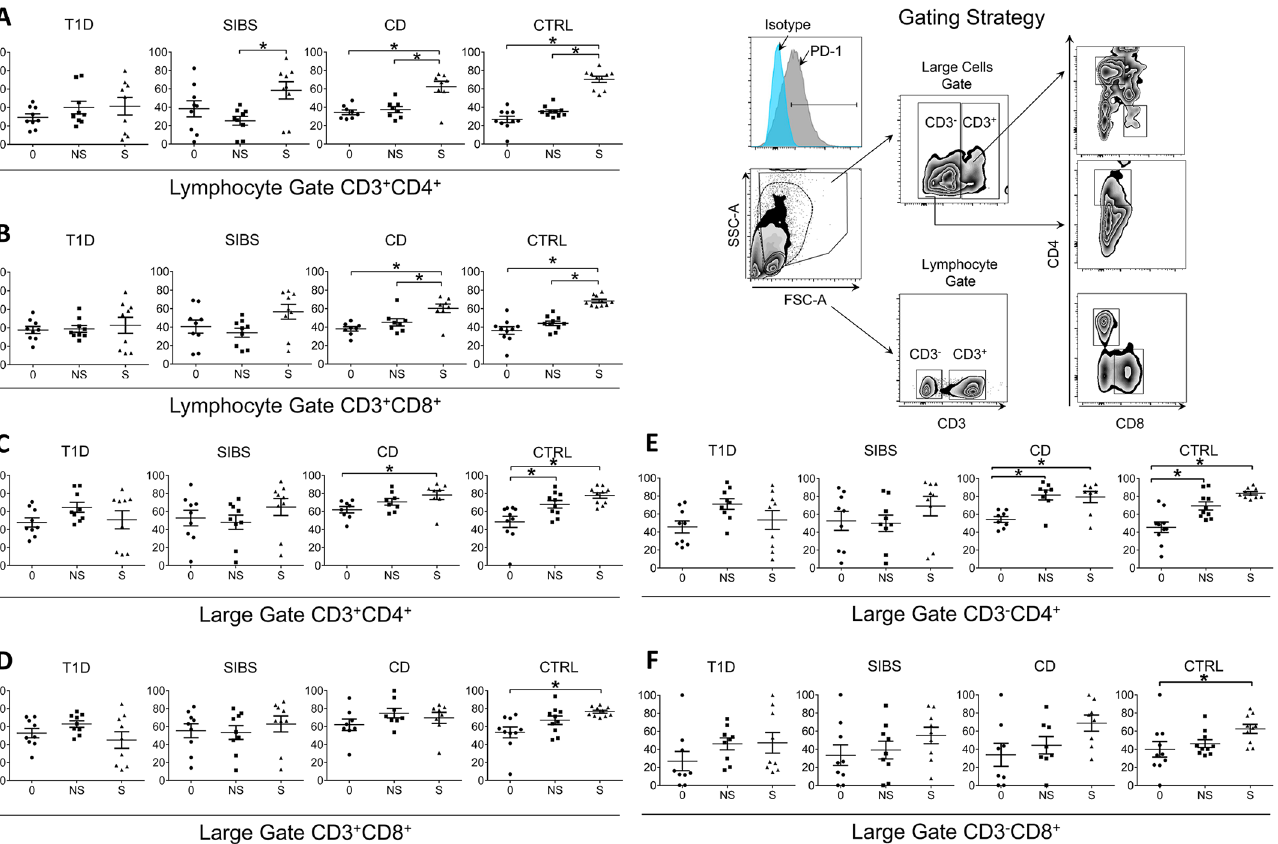
Fig 1. T Cells from T1D fail to upregulate PD-1 upon stimulation. Freshly isolatedPBMCs were stained with antibodiesagainstCD3, CD4, CD8, and PD-1 and analyzedby flow cytometry. Lymphocytes were identifiedby forward and side scatter and interrogatedfor CD4 and CD8 expression (bottom of right panel,lymphocyte gate). Another gate with higherside scatter identifiedlarger cells that includemonocytes and activated T cells (top of right panel, large gate). Mean percentage expressionof PD-1 was compared by one-wayANOVA on each of the PBMC subpopulations( A-F ). PercentagePD-1 surface expressionin PBMC subsets is shown, at time zero (0) and after 24 h in culture with (S) and without (NS) stimulation( * indicate p < 0.05).